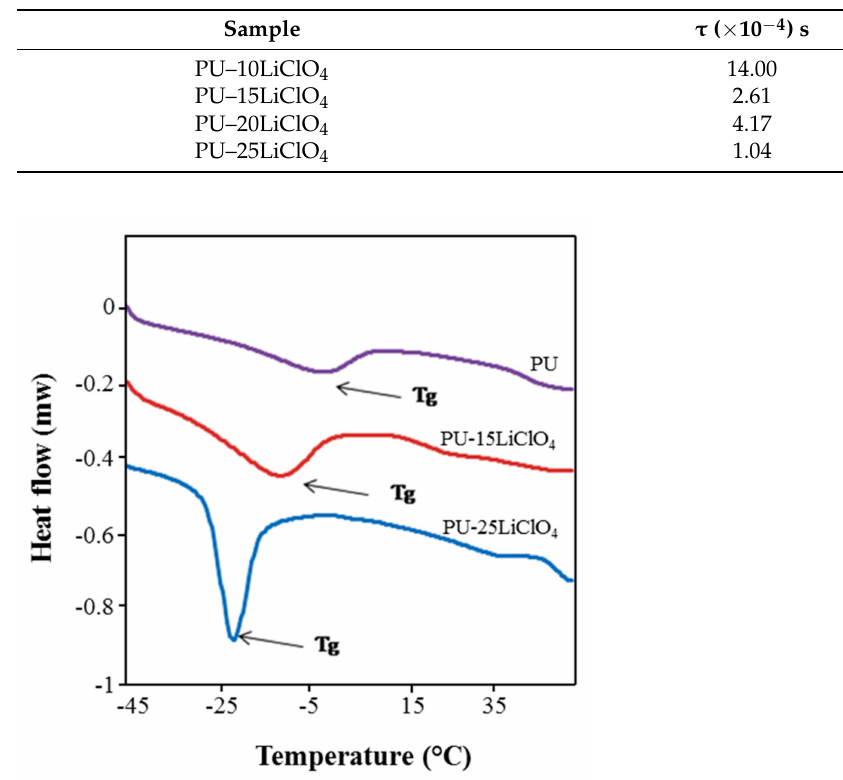
Figure 15. Tan δ versus log frequency of PU having 10 wt.% to 25 wt.% LiClO 4 . Table 4. Relaxation parameter of PU having 10 wt.% to 25 wt.% LiClO 4 .